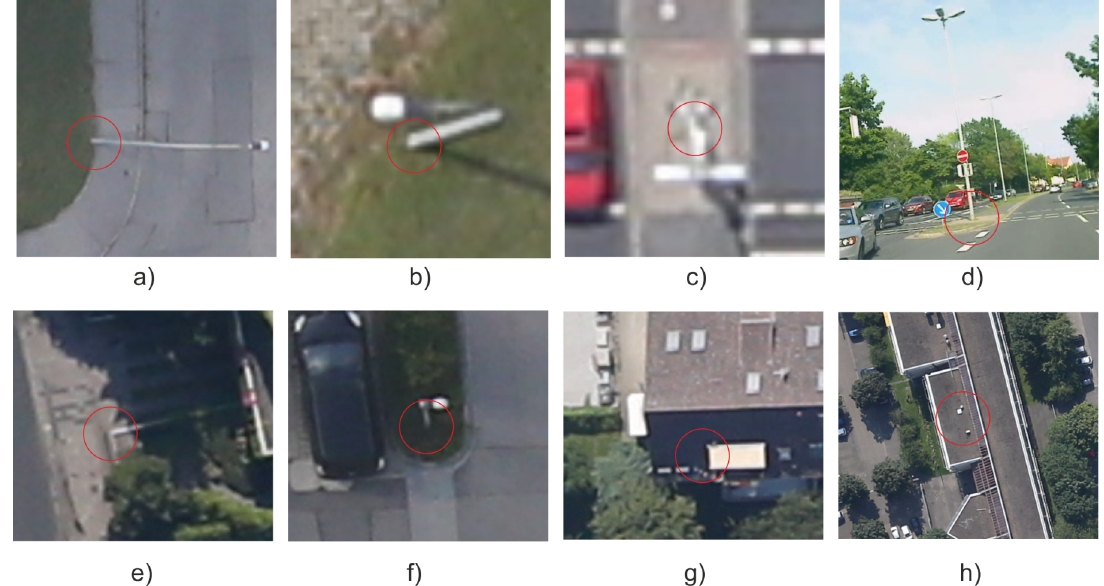
Figure 5. Examples of measuring the SAR-GCPs in aerial images: a) , b) , e) and f) measurements of pole foot points; c) pole foot point difficult to identify in the aerial image; d) street view image of pole in c) to identify the pole foot point; g) and h) SAR-GCPs on building roofs difficult to identify.